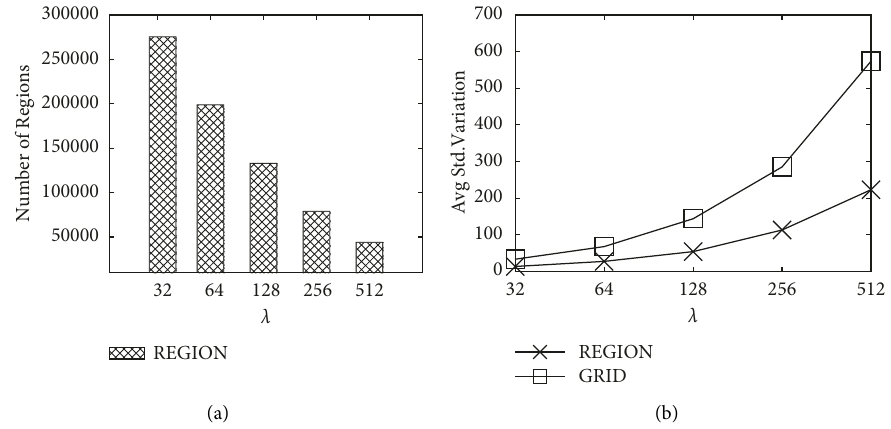
Figure 4: Varying threshold λ . (a) Number of generated regions. (b) Average standard variations.